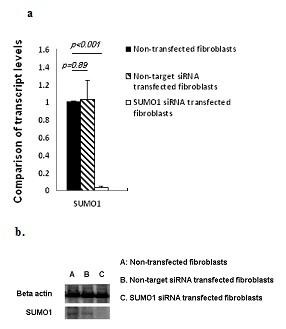
Real-time RT-PCR and Western blots for SUMO1 with and without SUMO1 siRNA transfection in fibroblasts. Three SSc fibroblast strains (two with anti-topo I and one with anti-RNA polymerase III positive serum) were transfected with SUMO1 siRNA. After 48-hour transfection, total RNAs were used for measuring SUMO1 transcript levels (Figure 4a), and the nuclear extracts were used for measuring SUMO1 protein (Figure 4b). Error bars indicate standard deviation.